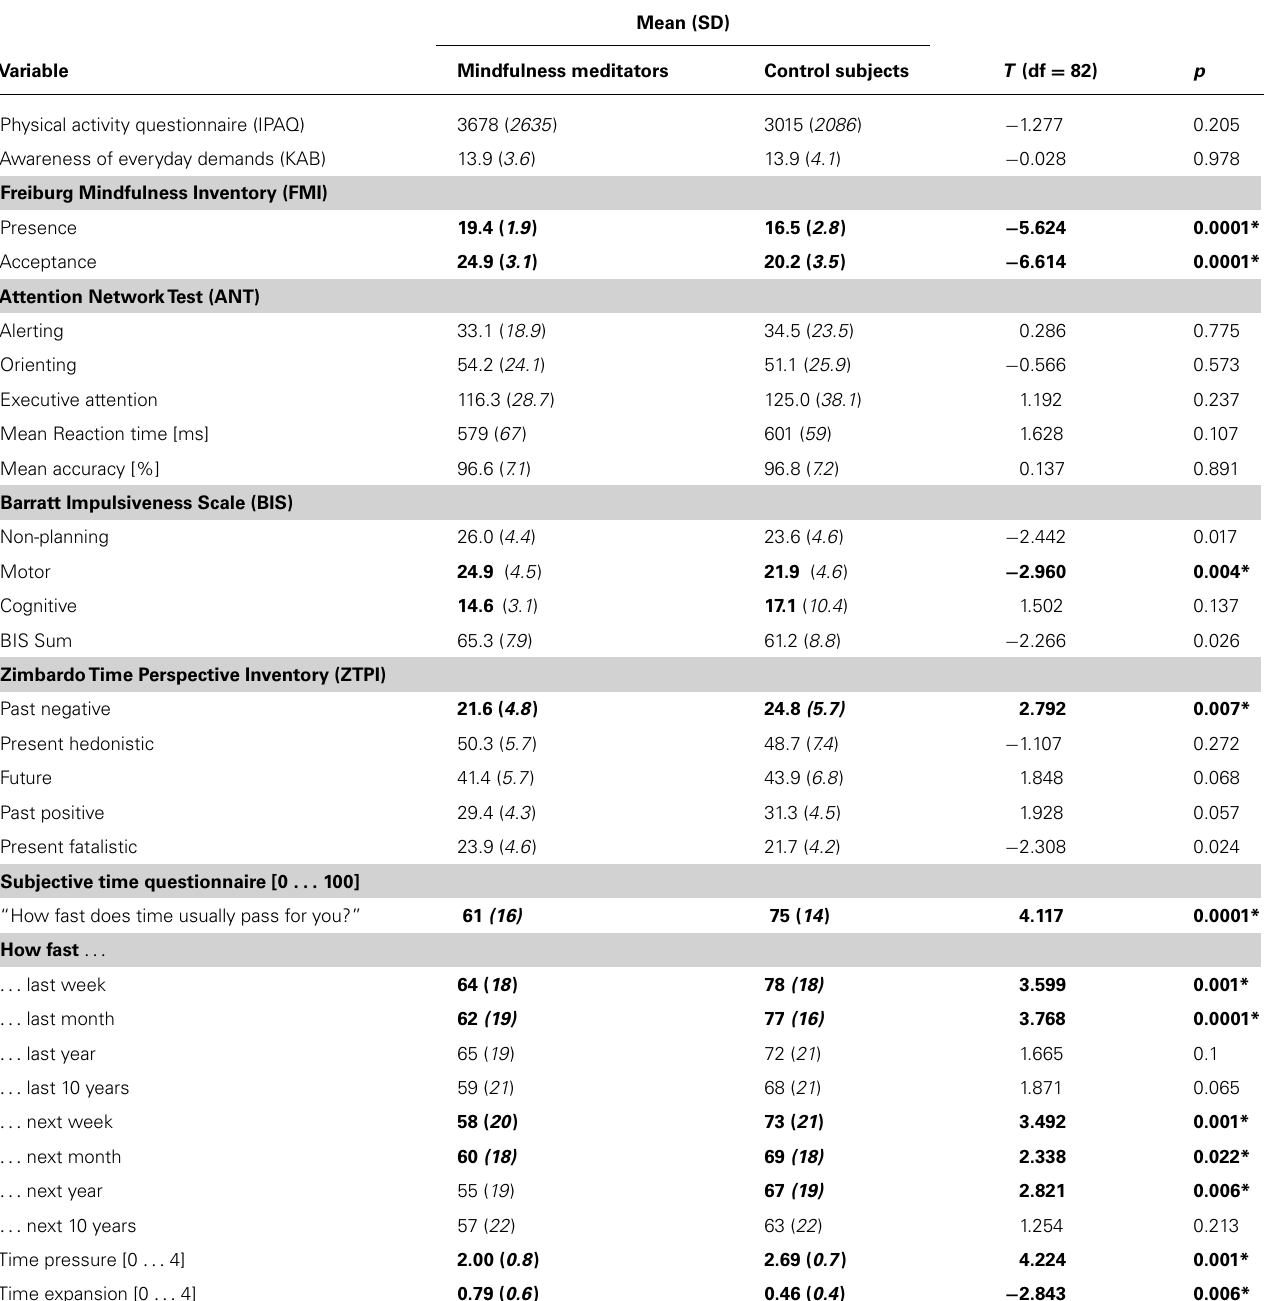
Table 1 | Mean group differences between meditators and control subjects in self-rating